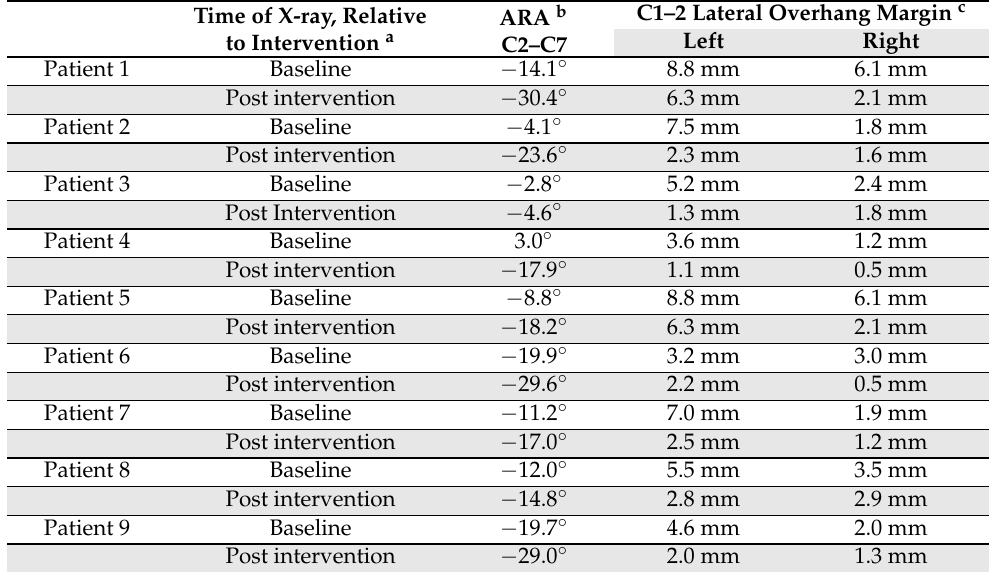
Table 2. Radiographic measurements, pre and post